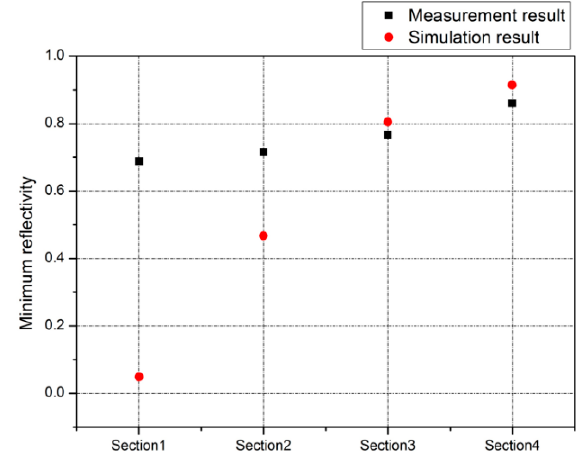
Figure 9. Measurement result of the fabricated SPR sensor chip.